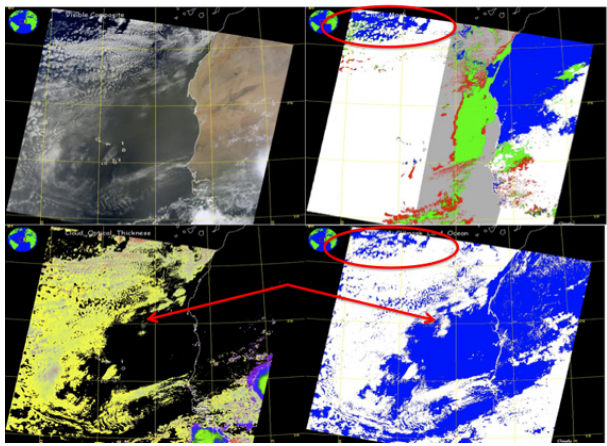
Fig. 2. Terra MODIS image from 12:00UTC 2 July 2010 showing (upper left) true color image of heavy dust spreading over the At- lantic from northern Africa. (Upper right) standard MODIS cloud mask (MOD35) with white areas identified as cloudy, gray as sun glint, red as probably cloudy, blue probably clear and green as clear. (Lower left) MODIS cloud optical thickness product (MOD06), and (lower right) MODIS aerosol cloud mask (MOD04) with white des- ignating cloudy and blue, cloud-free. This panel shows only the cloud mask, not the pixels chosen for aerosol retrieval. Aerosol re- trievals are not made in the sun glint region. The red oval identifies a region where the aerosol cloud mask finds more clouds than the standard cloud mask. The red arrow identifies an area that neither the cloud retrieval nor the aerosol retrieval chooses to use to derive cloud or aerosol properties,